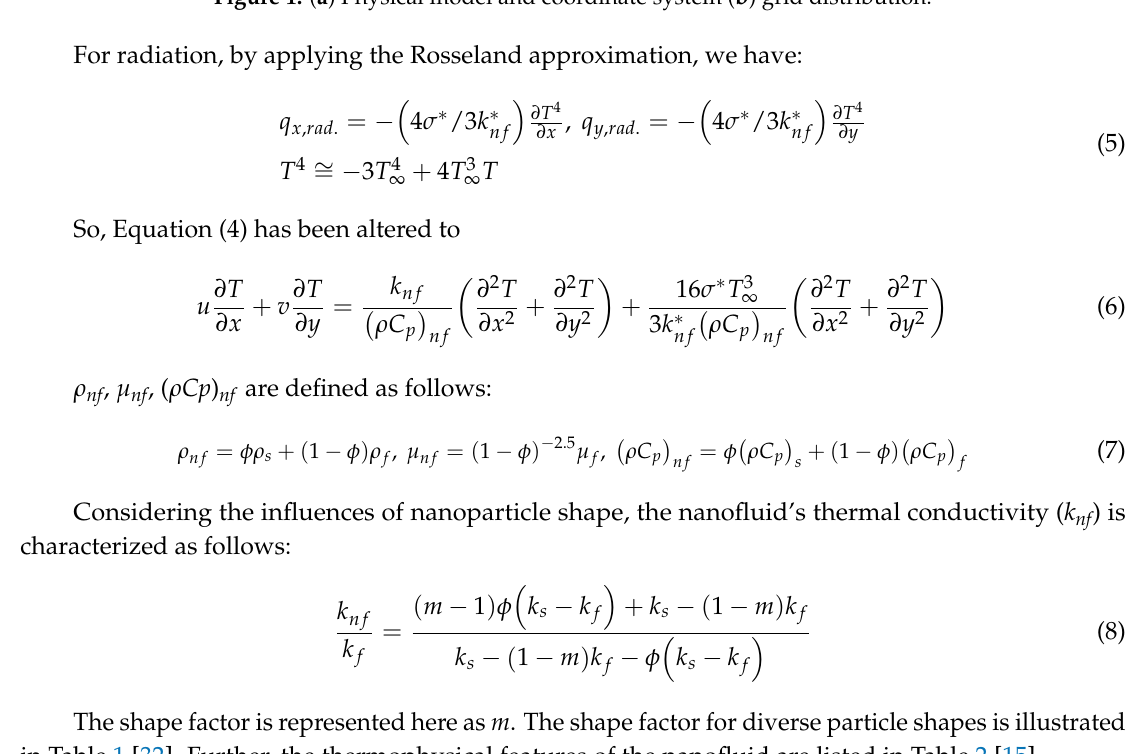
Figure 1. ( a ) Physical model and coordinate system ( b ) grid distribution.